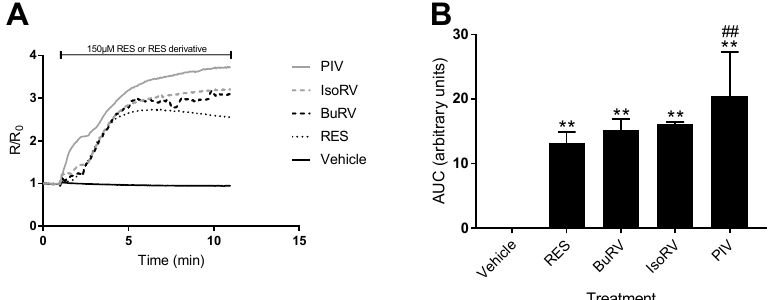
Figure 4. RES derivatives increase intracellular calcium levels. MDA-MB-231 cells were loaded with Fura-2, a calcium-sensitive fluorophore, to measure relative intracellular calcium levels. Fura-2-loaded MDA-MB-231 cells following 1 min of baseline collection were treated with 150 μ M RES (dotted, black), BuRV (dash, black), IsoRV (dash, gray), PIV (solid, gray), and a vehicle control (solid, black). The data are represented as line traces ( A ) of the relative changes in intracellular calcium, and the area under the curve (AUC) quantified in the bar graph ( B ). Results are representative of three biologic samples. ** indicates p < 0.01 compared to the vehicle only control, and ## indicates p < 0.01 compared to RES.